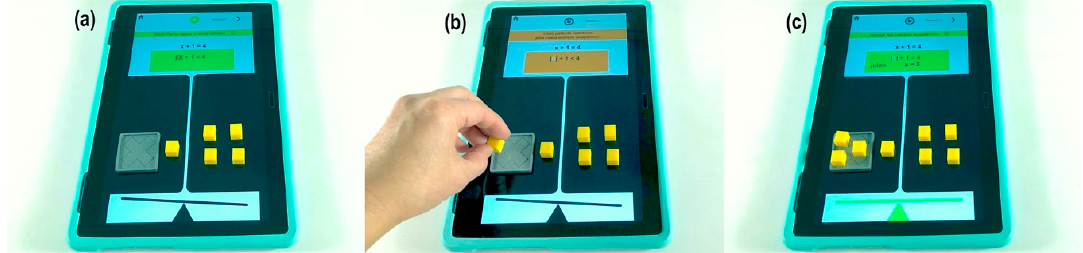
Figure 4. The steps to complete the Level 1 exercise x + 1 = 4. ( a ) Modelling the given equation;